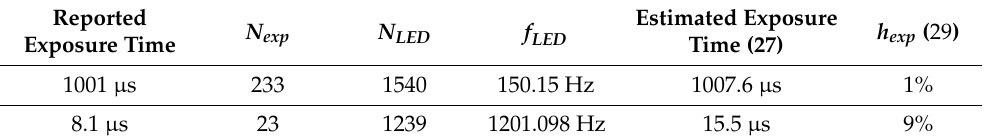
Table 6. Parameters of two example measurements of C3, using the equivalent sampling method.